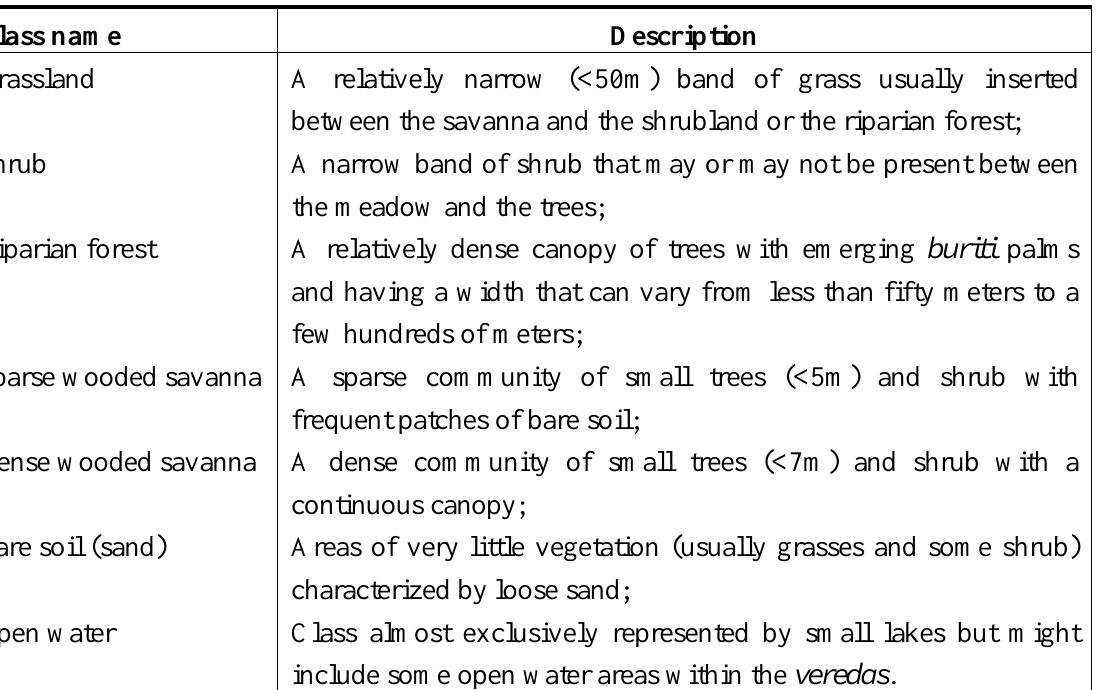
1 . Class name and description of vegetation type of the veredas and surrounding